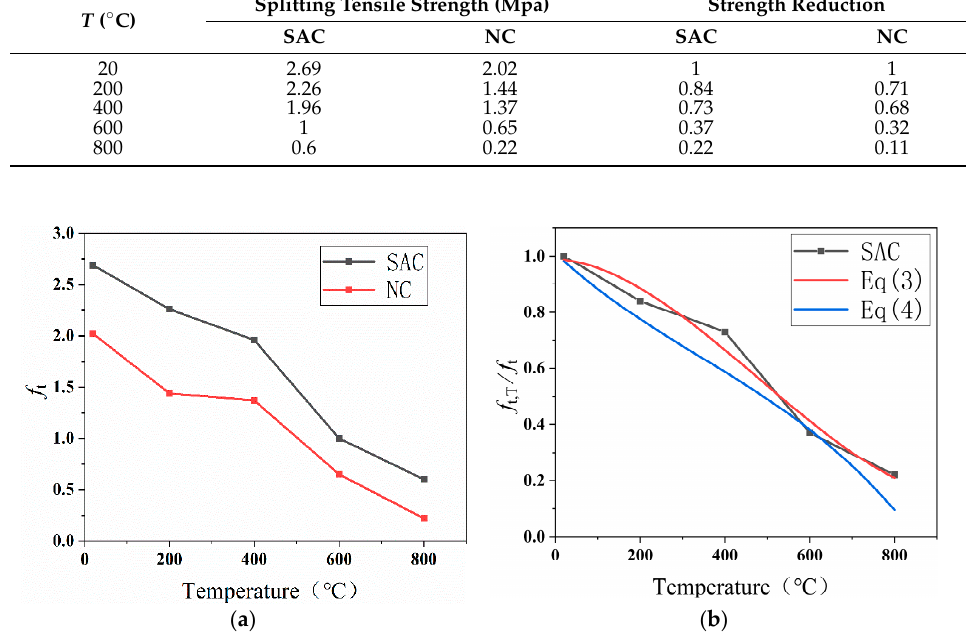
Figure 7. Splitting tensile strength. ( a ) Reduction of splitting tensile strength. ( b ) Relative reduction of splitting tensile strength. Table 3. Splitting tensile strength of specimens after high temperature.